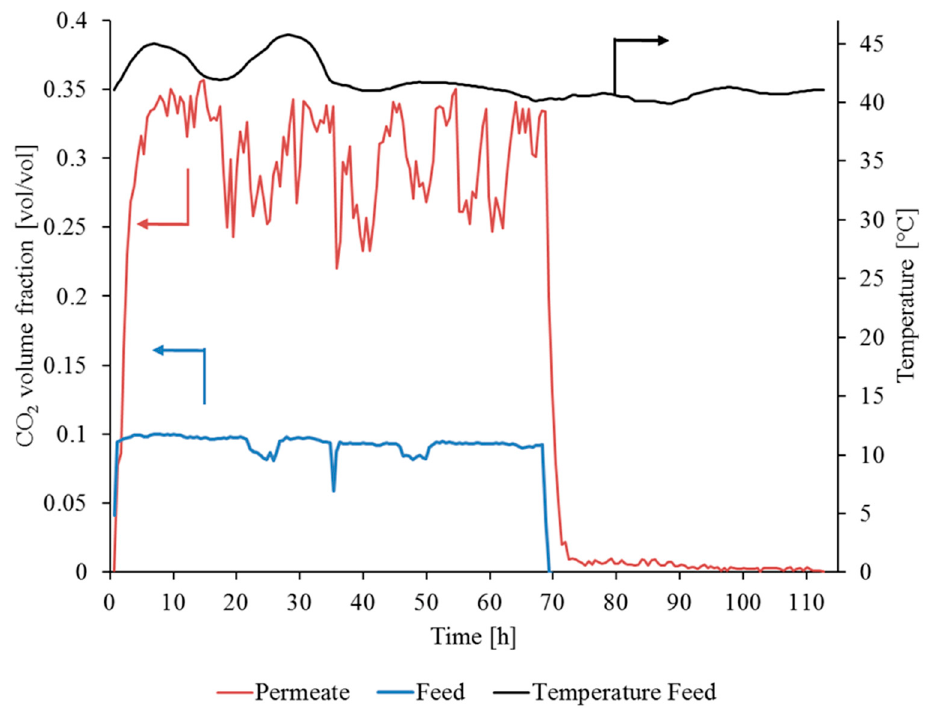
. , ϑ F , V N,F ~0.12 m 3 (STP)/h, p F,CO 2 , ϑ F , V(cid:4662) (cid:2898),(cid:2890) ~0.12 m 3 (STP)/h, p (cid:2926) ~20 mbar. (cid:3118)